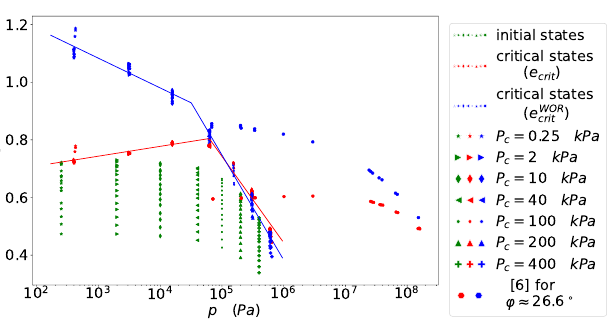
Figure 5. Initial void ratio against generation inter-particle fric-